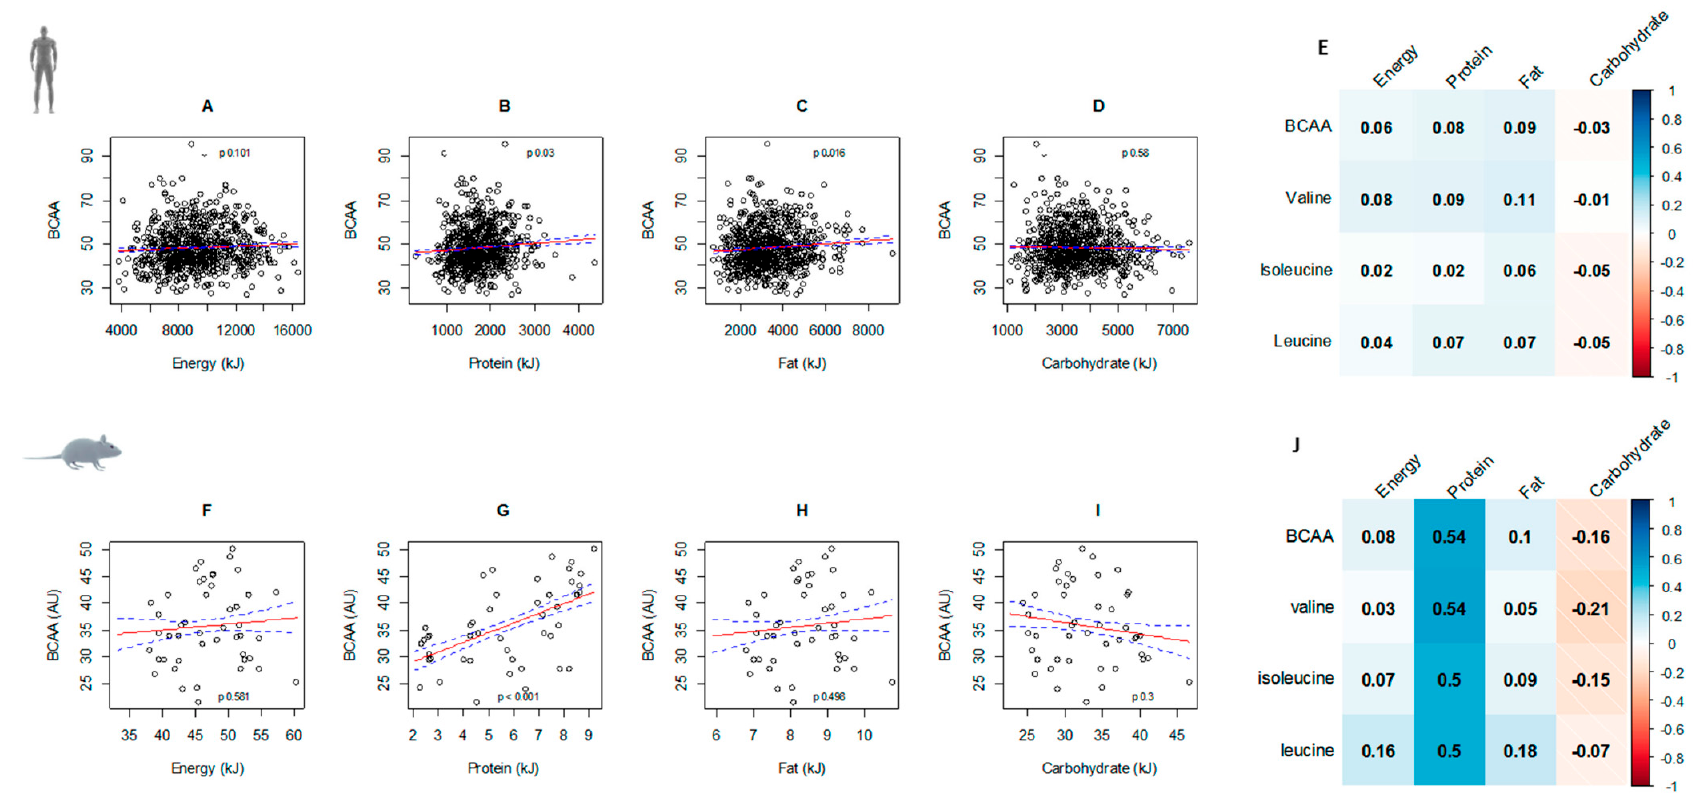
Figure 2. Circulating BCAA (branched chain amino acid) vs. nutrient intake in older men ( A–E ) and mice ( F–J ). Red lines represent fitted values and blue dotted lines represent 95% confidence intervals. In both humans and mice, protein intake was associated with higher circulating BCAAs ( B , G ). Men who consumed a diet high in fat were more likely to have higher circulating BCAAs ( C ). Correlation matrices show a similar pattern of correlation between dietary intakes and individual BCAAs in both men ( E ) and mice ( J ).